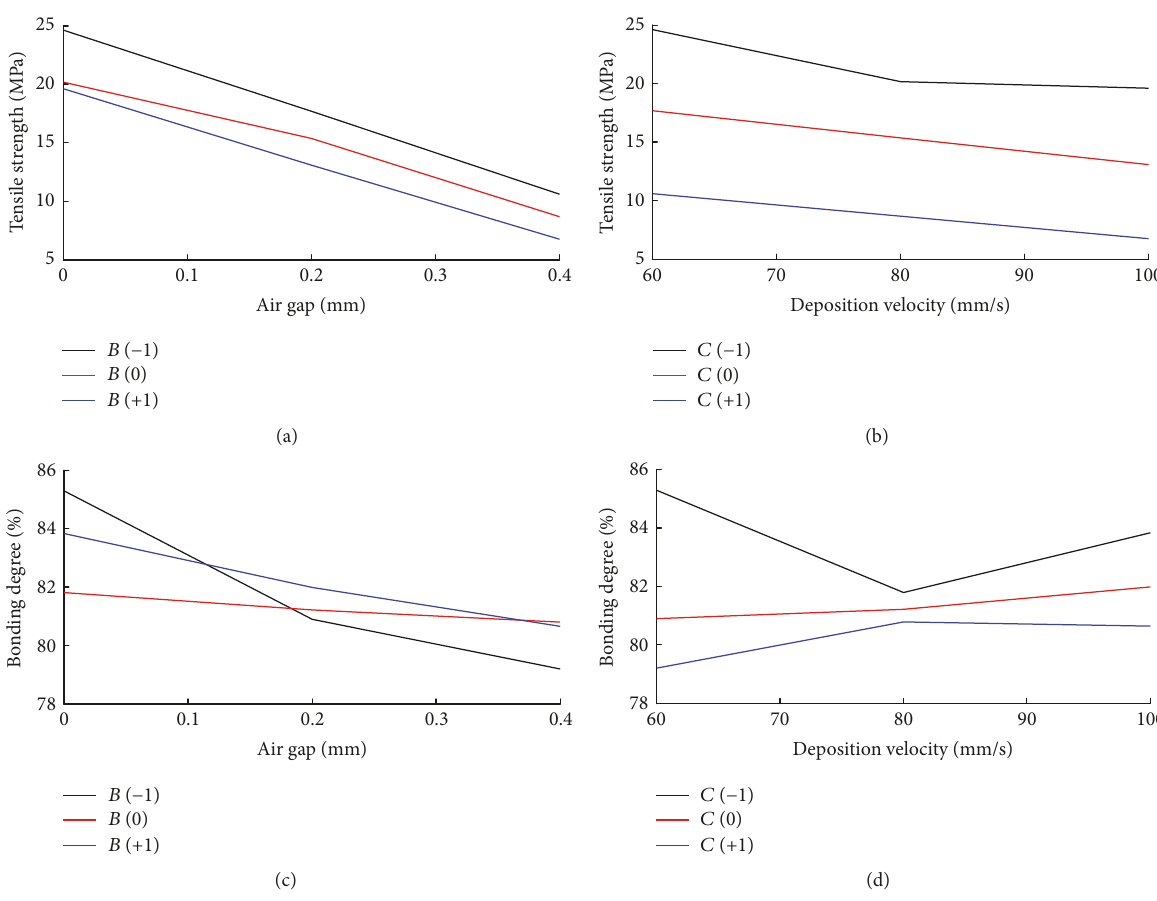
Figure 8: The change of tensile strength and bonding degree with different deposition velocities and air gaps.